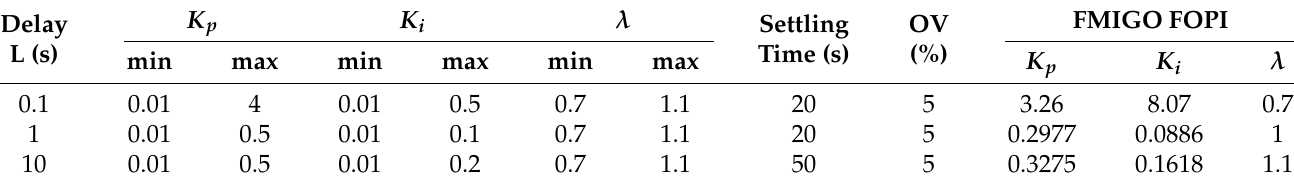
Table 1. SOC benchmark configuration parameters.